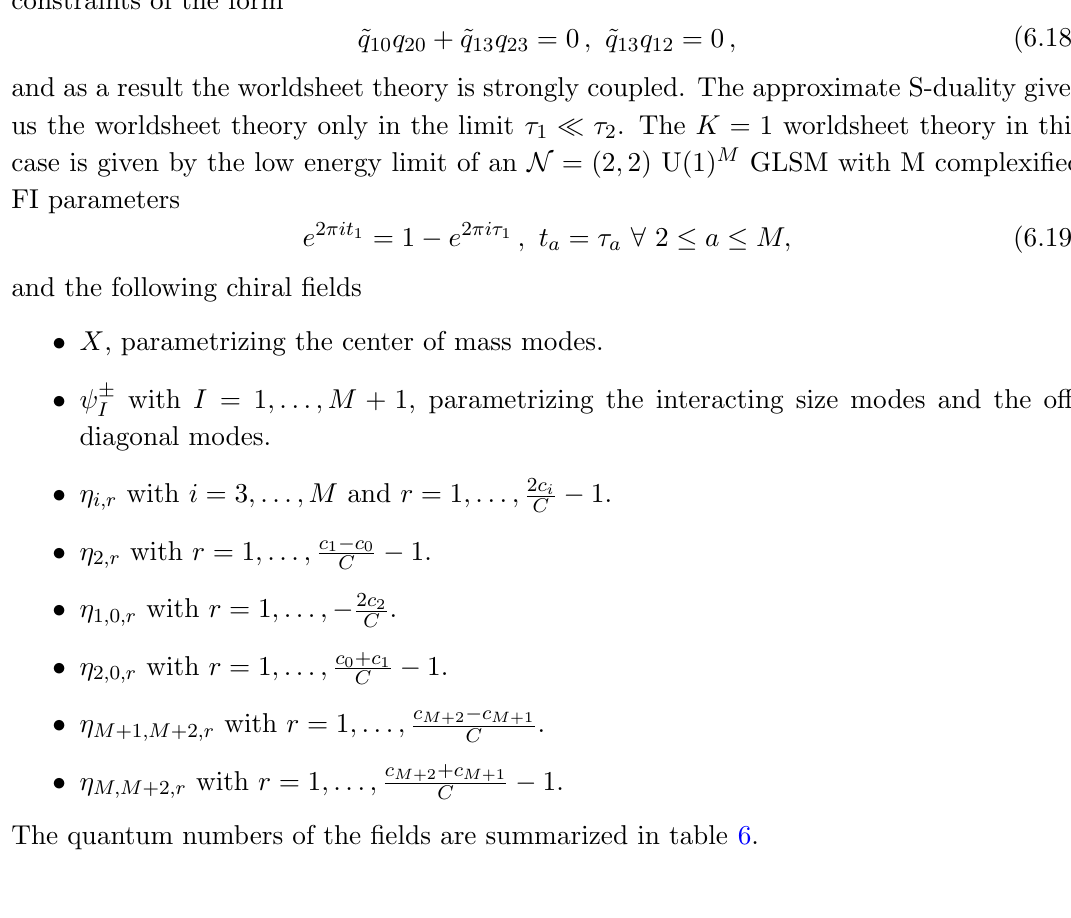
of SU(2) is pseudoreal, and therefore we can exchange mesons with baryons, and take